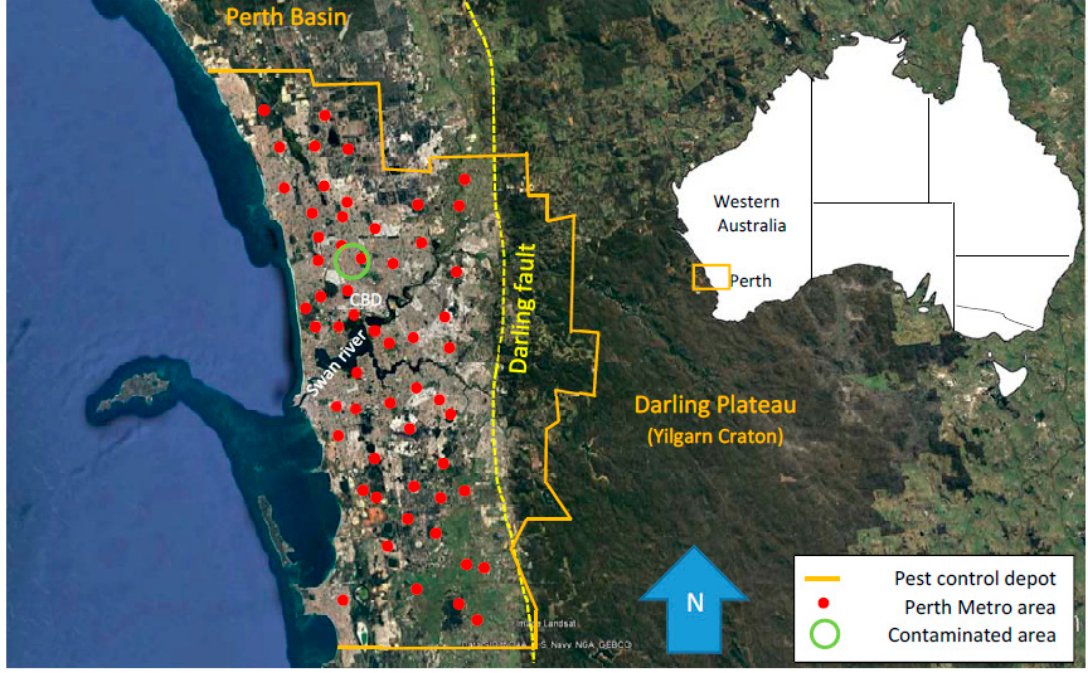
Figure 1. Depot pest control locations in Perth (idea from [39]) and contaminated groundwater spots by atrazine [40].